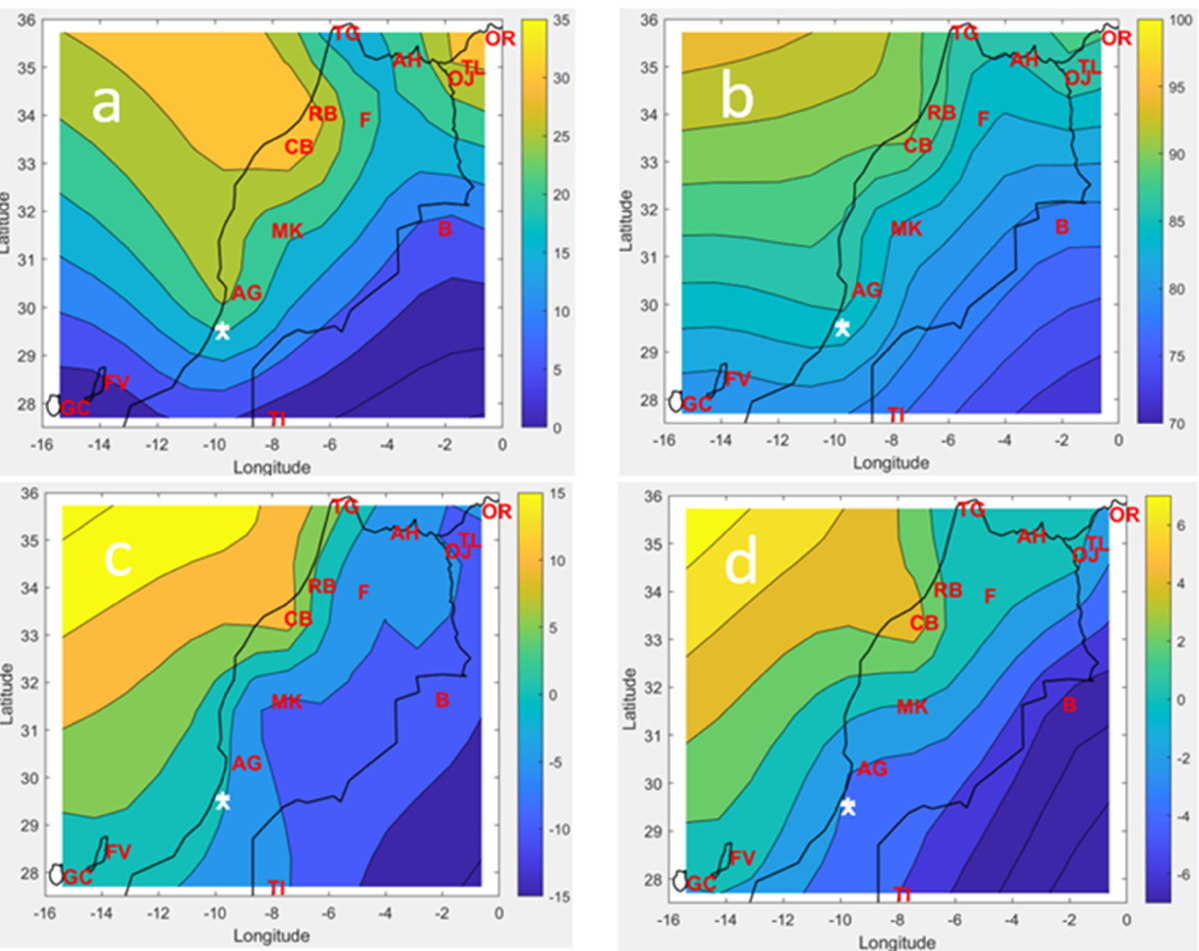
Figure 2. ( a ): Map of mean yearly dew yield H d,y (mm·yr − 1 ) for the period 2005–2020 (see text and Table 2). ( b ): Mean yearly nocturnal RH (%) during dew events during the same period. ( c ) Variations between years 2005 and 2020 of the yearly dew yield H d,y (mm·yr − 1 ). ( d ): Variations between years 2005 and 2020 of relative humidity RH (%). Red letters: Meteo sites (see Table 1). Right and inclined white crosses (very close) are, respectively, the sites of Mirleft (43 m asl, 200 m from the coast) and Id Ouasskssou (240 m asl, 8 km from the coast)